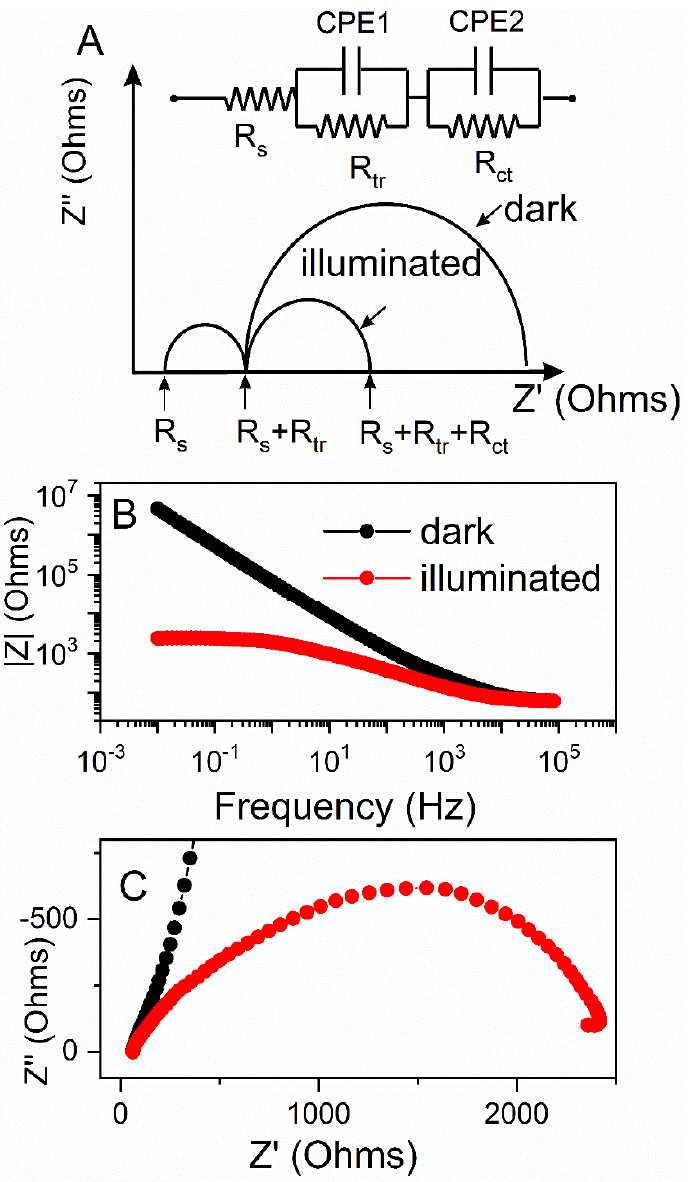
Figure 7. Theoretical impedance spectra and an electrical equivalent circuit representing distribution of the resistance in photoelectrochemical cell under dark and illumination ( A ); an example of Bode diagram | Z | = f( frequency ) ( B ), and Nyquist plot Z’ = f( Z” ) ( C ) under dark (black) and illuminated (red) conditions.